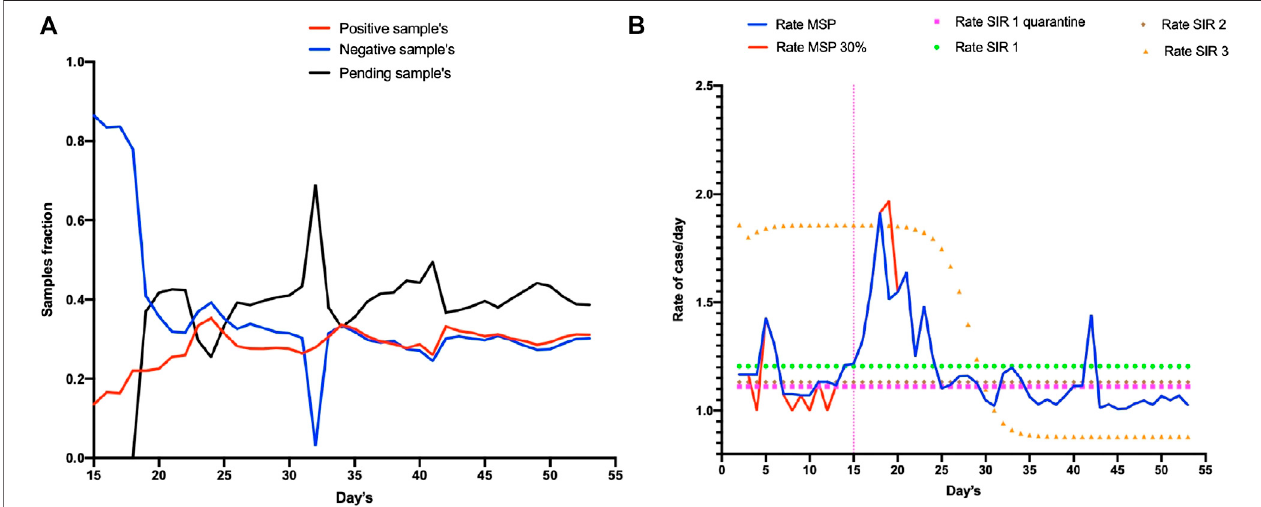
Frontiers in Applied Mathematics and Statistics |